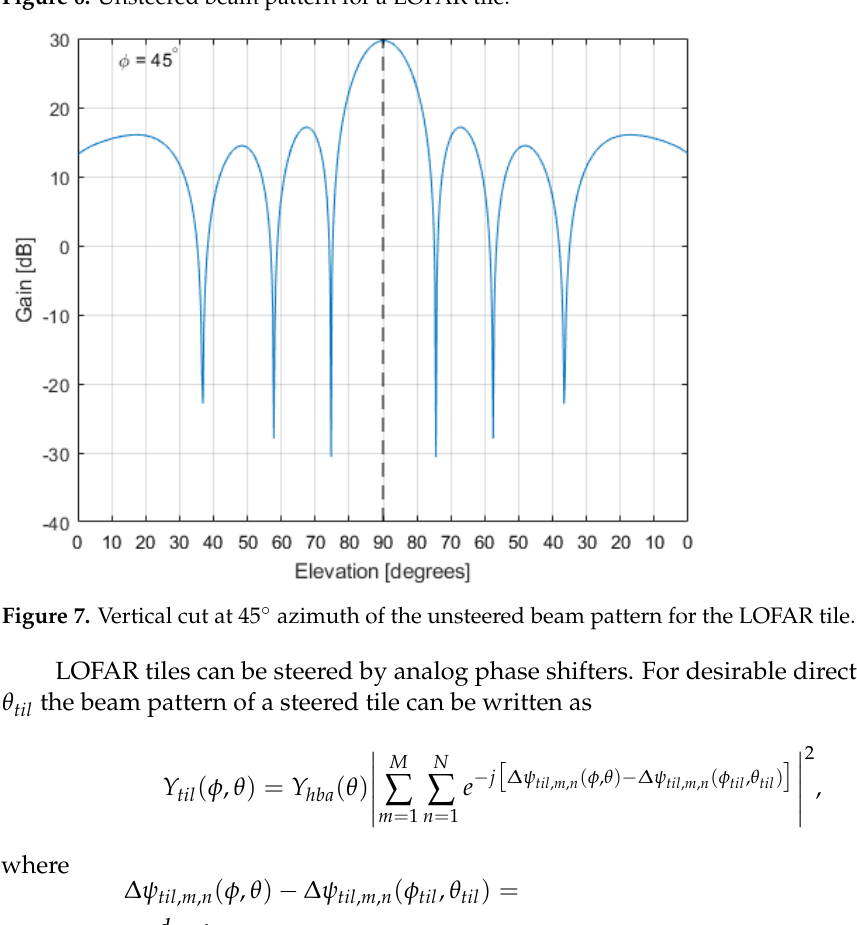
Figure 6. Unsteered beam pattern for a LOFAR tile.